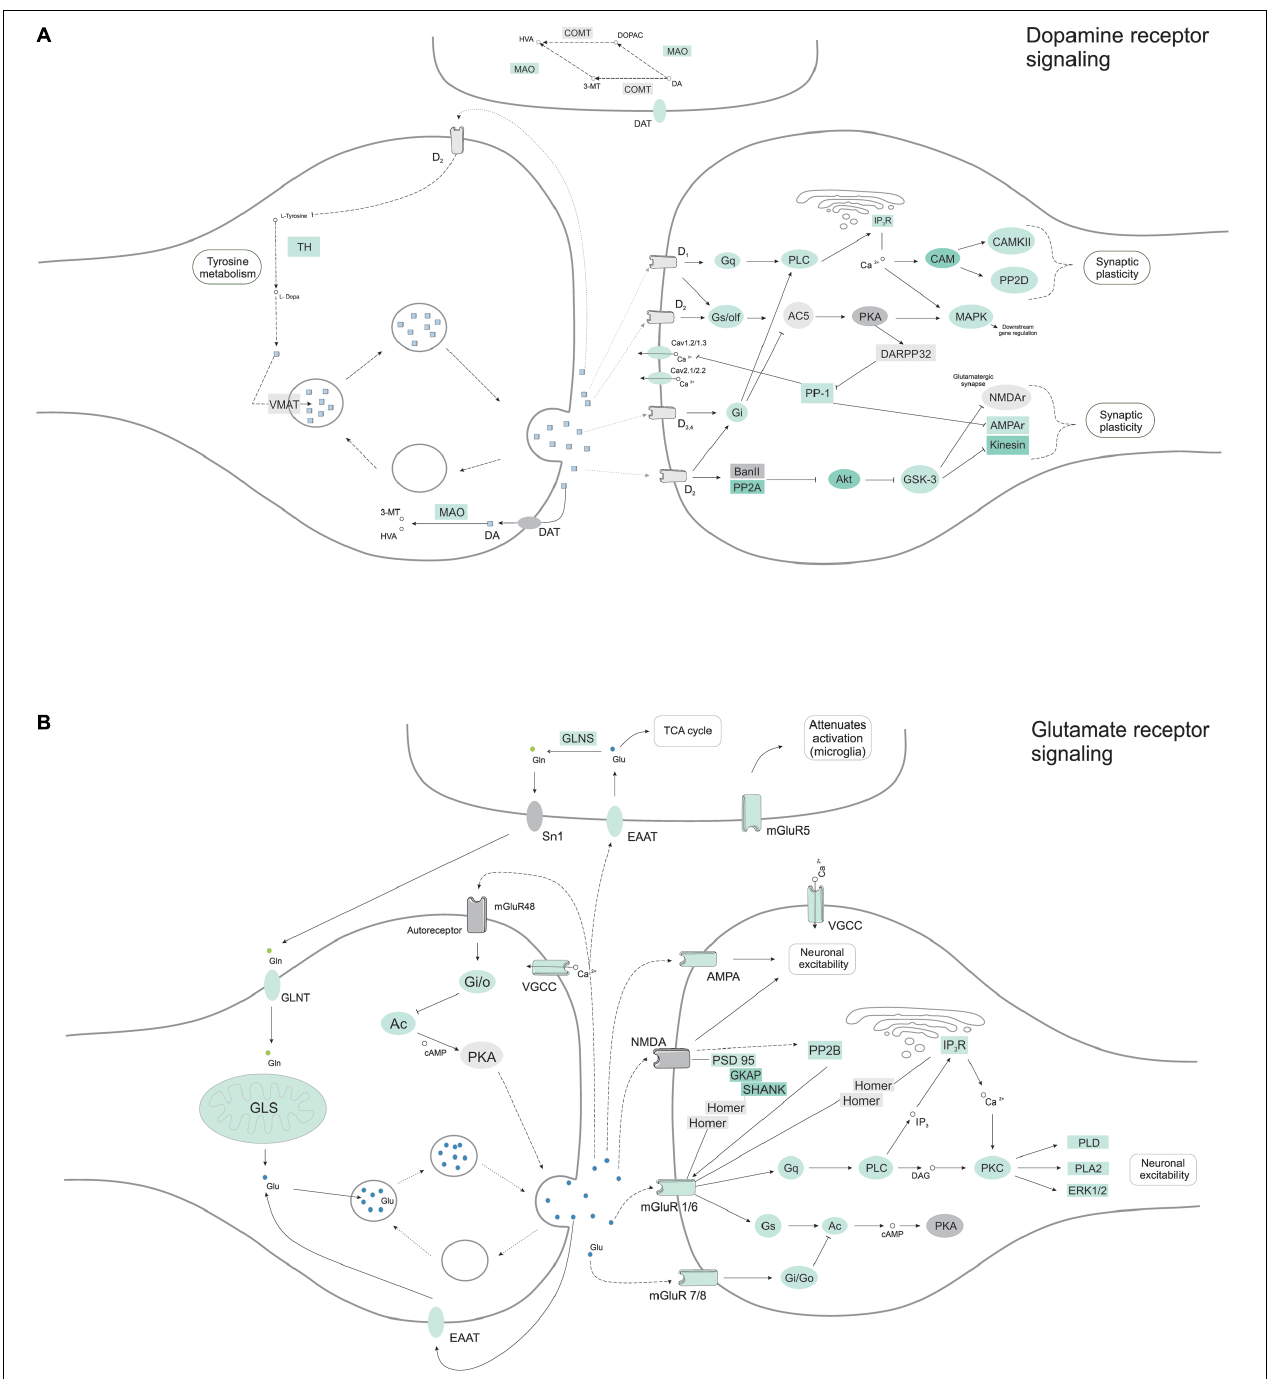
FIGURE 7 | Neuronal molecular pathways indicate glutamate and dopamine receptor signaling, in a representation of 45-day cerebral organoid proteomes. Pathway interactions of (A) dopamine and (B) glutamate receptor signaling were analyzed from the proteome dataset using the KEGG database (http://www.kegg.jp/). Proteins found in proteomic analyses are colored in green, while gray proteins were not found in the